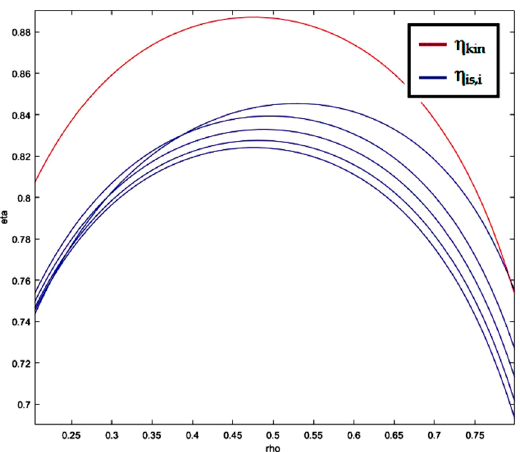
Figure 10. Comparing the variation of η kin and η is with ρ r for fixed χ and β out and different flow velocity.